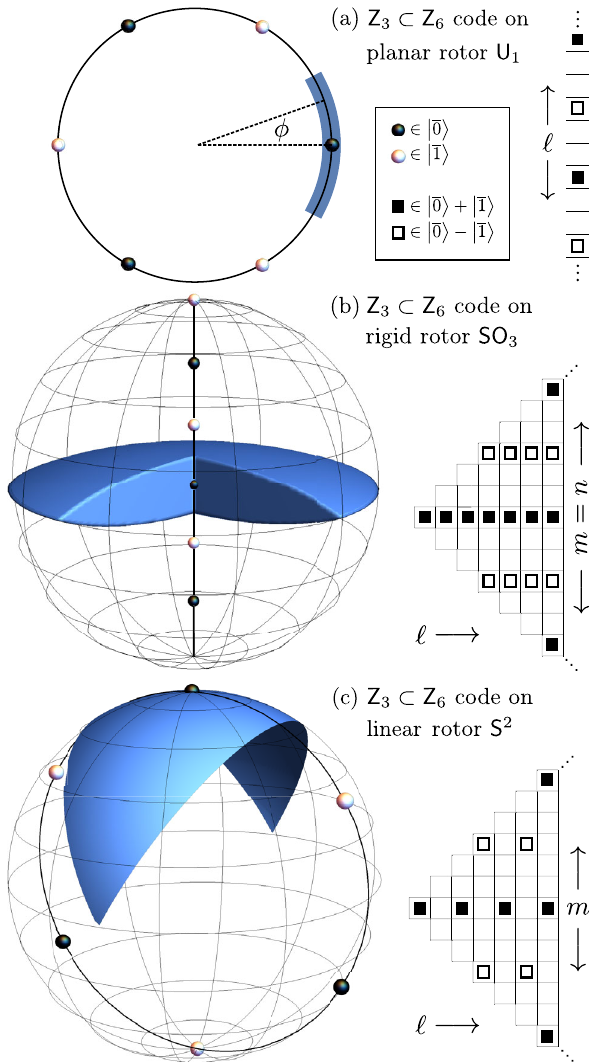
FIG. 2. Code word constructions. (a) Left: Sketch of the planar- rotor state space U 1 . Black and white points represent the positions present in the two code words (10) of the Z 3 ⊂ Z 6 GKP rotor code. Correctable shifts ð − π = 6 ; π = 6 (cid:2) are highlighted in blue. Right: U 1 angular-momentum ladder l ∈ Z. Black and white squares re- present momentum states present in the logical- X code words (11). (b) Sketch of the same features of the Z 3 ⊂ Z 6 molecular code (45). Left: Position space is drawn as a ball of radius π with antipodal points identified, and each SO 3 rotation by angle ω around axis v ∈ S 2 corresponds to the vector ω v on the ball. The set of correctable rotations is in blue, but part of it is cut out to show that it contains the origin (meaning that small rotations around any axis are correctable). Right: Momentum space is a 3D square pyramid with the height labeled by l and the base by j m j , j n j ≤ l . We plot only the m ¼ n part, where the code words (49) have support. (c) Sketch of similar features of the Z 3 ⊂ Z 6 linear-rotor code (102), whose states are equal superpositions of equidistant orientations along an equator. Left: The blue spherical lune contains all points that are closer to the enclosed black point than to any other black or white point. Right: Momentum space is a 2D pyramid with base j m j ≤ l , showing states participating in the logical- X code words